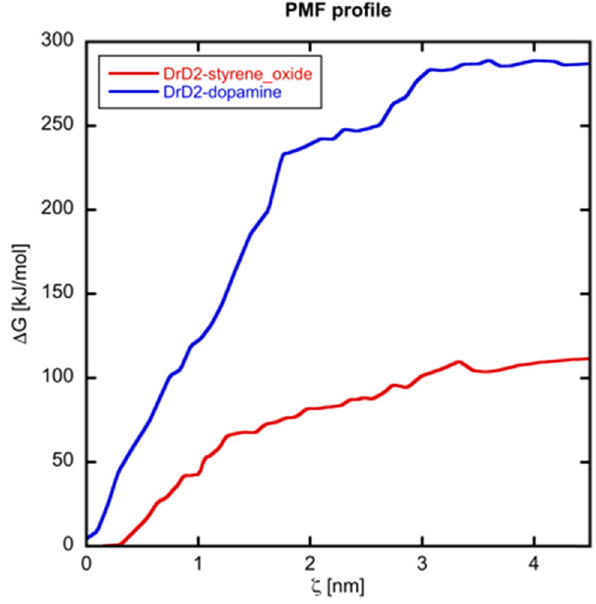
Figure 6: Potential of mean force for the binding of the two studied ligands to the DrD2 receptor.